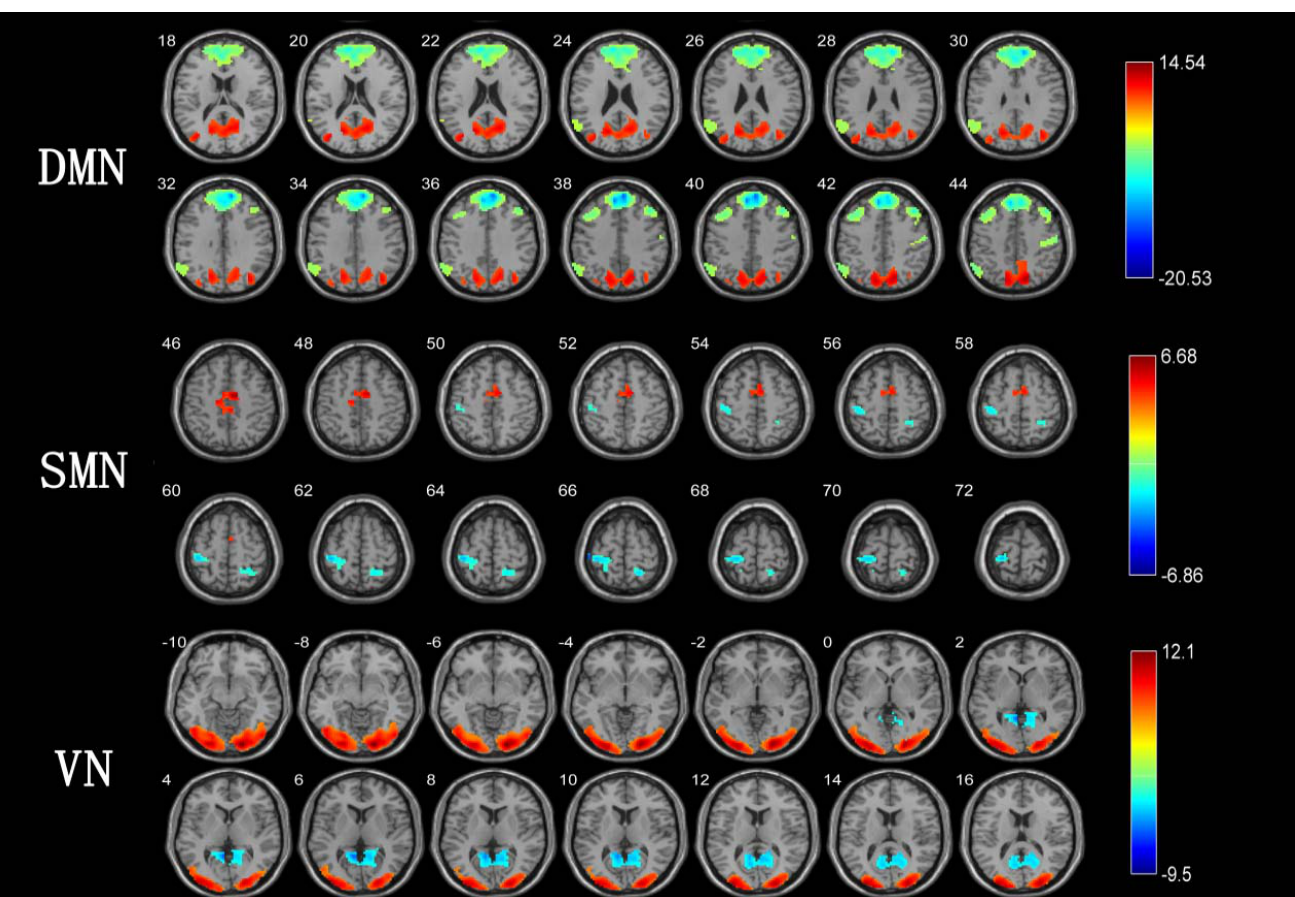
Figure 2. Different results of brain network between TCC group and walking group. Note: Figure 2 is the different results of brain network between TCC group and walking group. Red represents the brain area of the TCC group greater than that of the walking group, blue represents the brain area of the walking group greater than that of the TCC group, and the color bar on the right represents the t ‐ value. p < 0.05, voxel number >20. The results DMN (default mode network), SMN (sensory ‐ motor network), and VN (visual network) were corrected by family ‐ wise error.